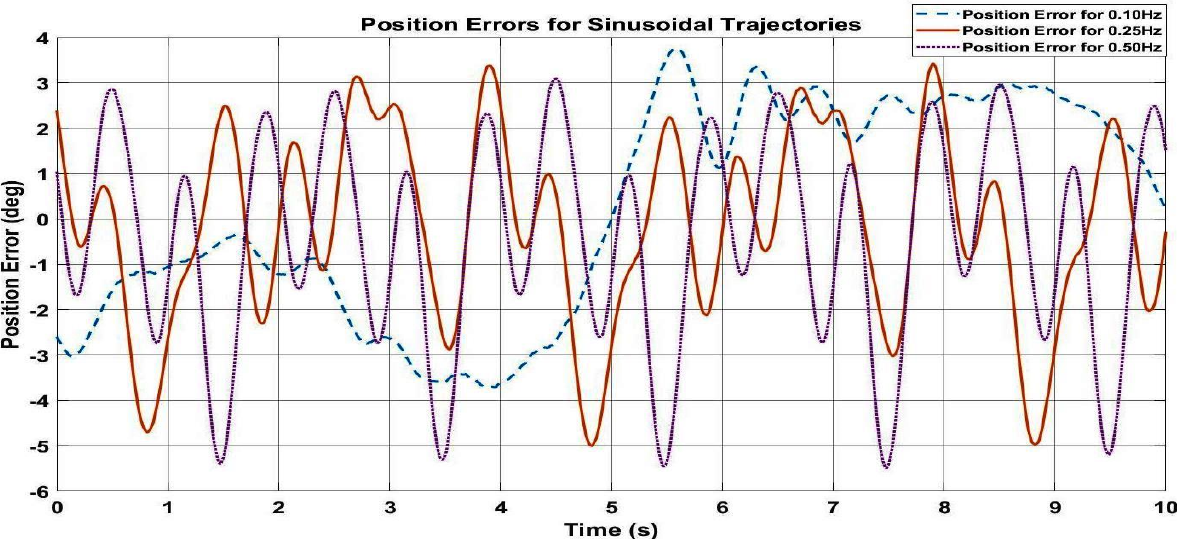
Figure 18. Position errors for sinusoidal trajectories when NARX estimation-based control is ac- tive.